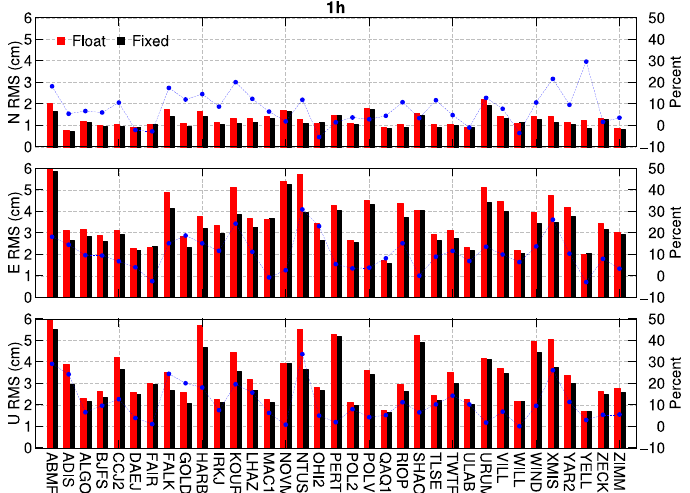
Figure 10. RMS of the float and fixed position estimates for 1 h hourly data length with respect to the weekly estimates for 35 stations during 7days.